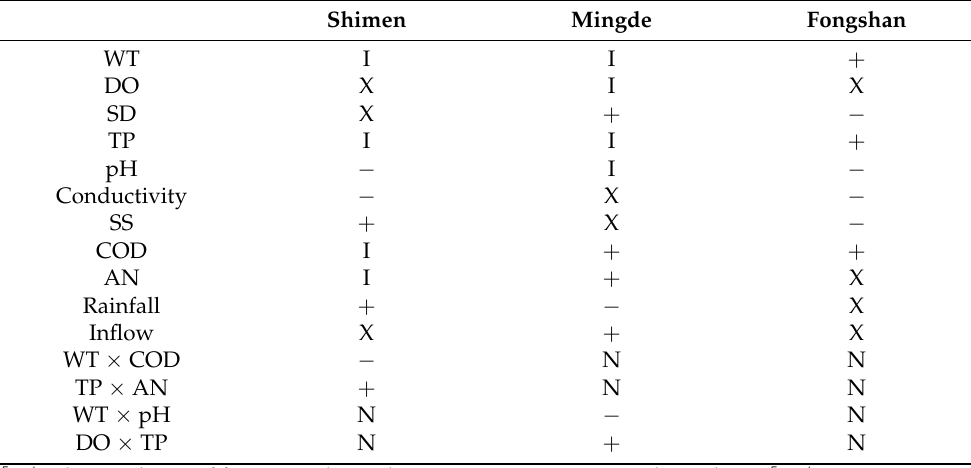
Table 11. Correlation of factors from the Shimen, Mingde, and Fongshan